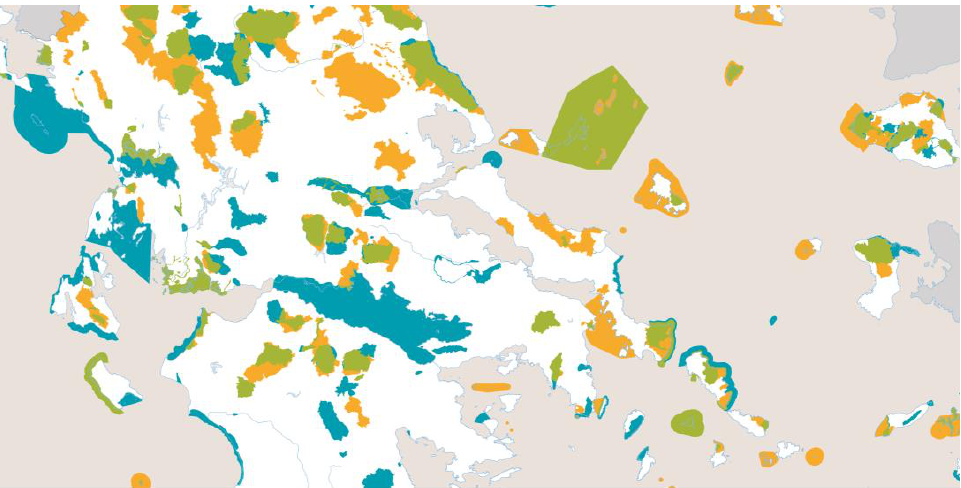
Figure 2. Natura 2000 map of Greece in detail, showing the protected zones dispersed in the greater territory. Ideally, these areas should form a continuous network with smooth transitioning between them to promote interactions, exchanges, and energy flows across the whole region.